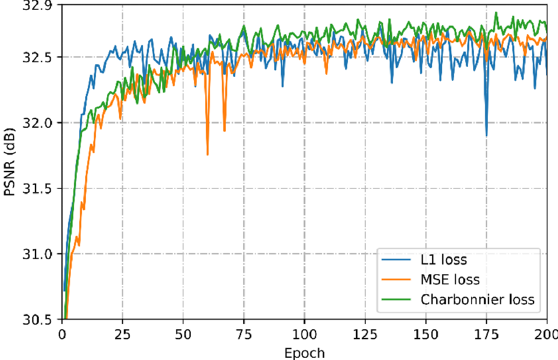
Figure 6. Performance analysis of different loss functions on the DIV2K dataset with 4×.